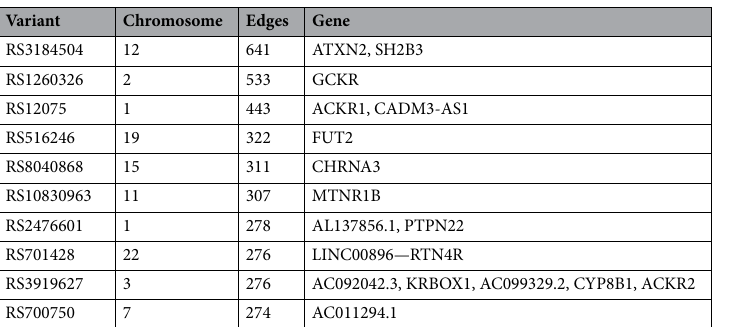
Table 2. Top variants found in the phenotypic network. Table showing the variants responsible for creating the greatest number of edges in the Phenotypic Network. Information includes the number of edges and the gene associated with that variant. The gene-variant relationships are acquired from the GWAS Catalog. For variants occurring in intergenic regions, both the upstream and downstream genes are shown.